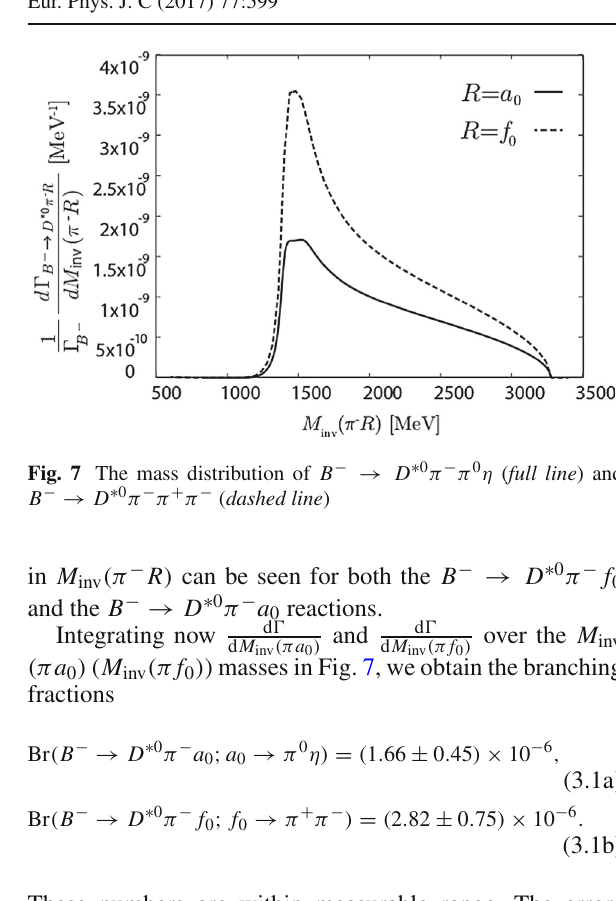
in M inv (π − R ) can be seen for both the B − → D ∗ 0 π − f 0 and the B − → D ∗ 0 π − a 0